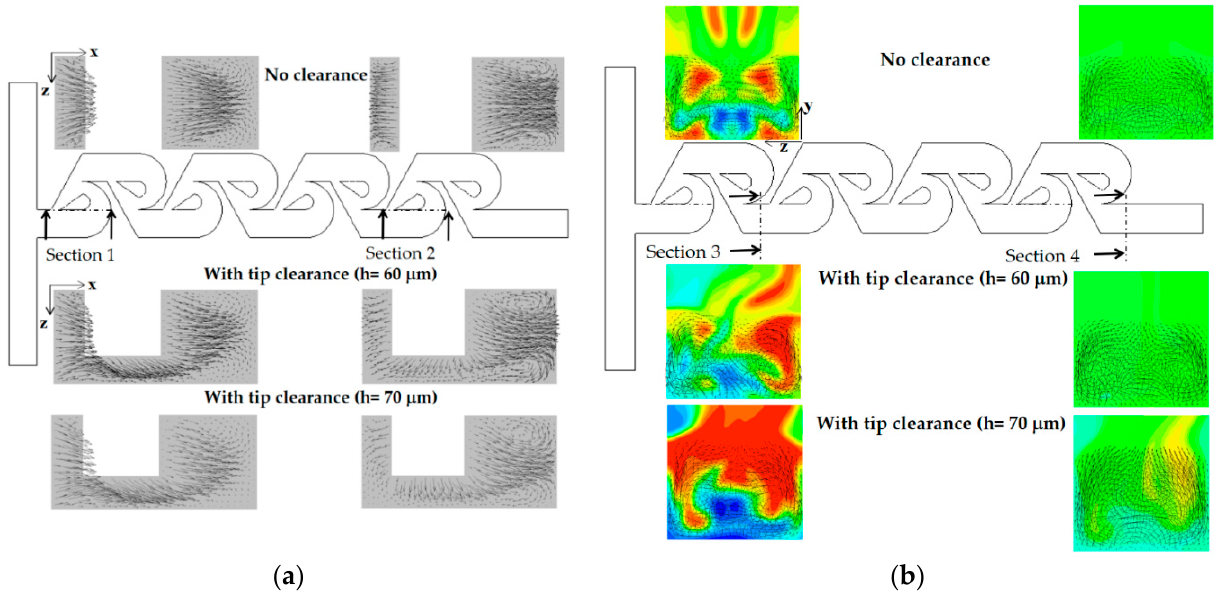
Figure 18. Concentration contours and velocity vector on the several planes for Re = 80: ( a ) velocity vector ( b ) concentration contours.